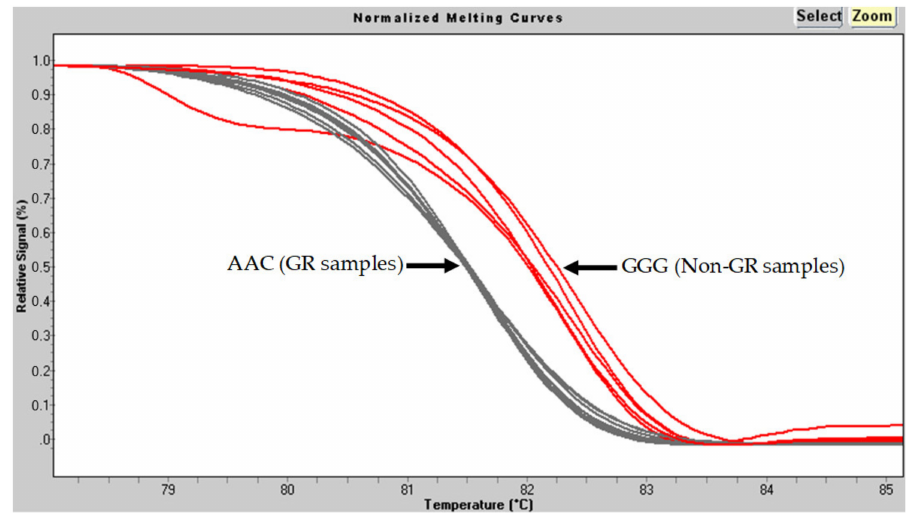
Figure 1. Normalized SA-HRM traces corresponding to the SARS-CoV-2 positive samples within relative fluorescence/temperature plots forming two clearly distinctive groups.